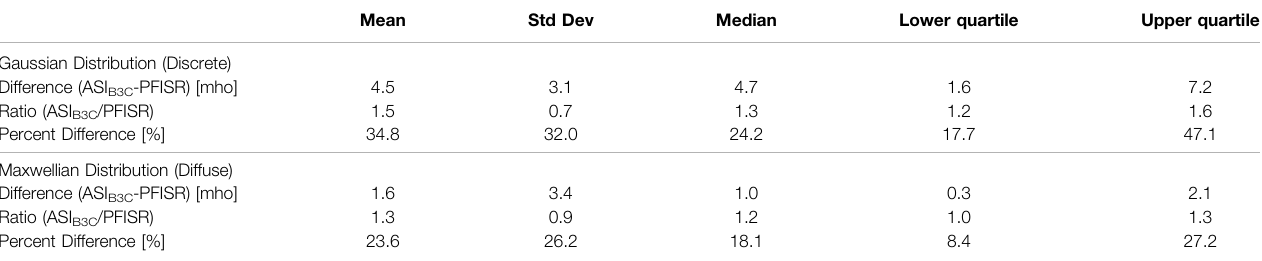
TABLE 2 | The mean and standard deviations, median and quartiles of the differences, ratios, and percent differences between the various B3C informed by ASI (ASIB3C) and PFISR results. Mean Std Dev Median Lower quartile Upper